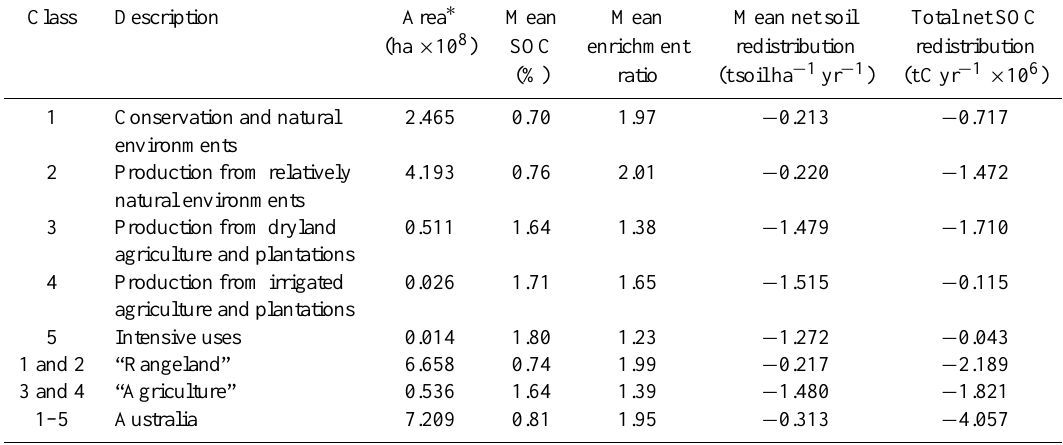
Table 1. Calculation of soil organic carbon net (1950s–1990) redistribution and its proportion for land use classes across Australia. Class Description Area ∗ Mean Mean Mean net soil SOC Conservation and